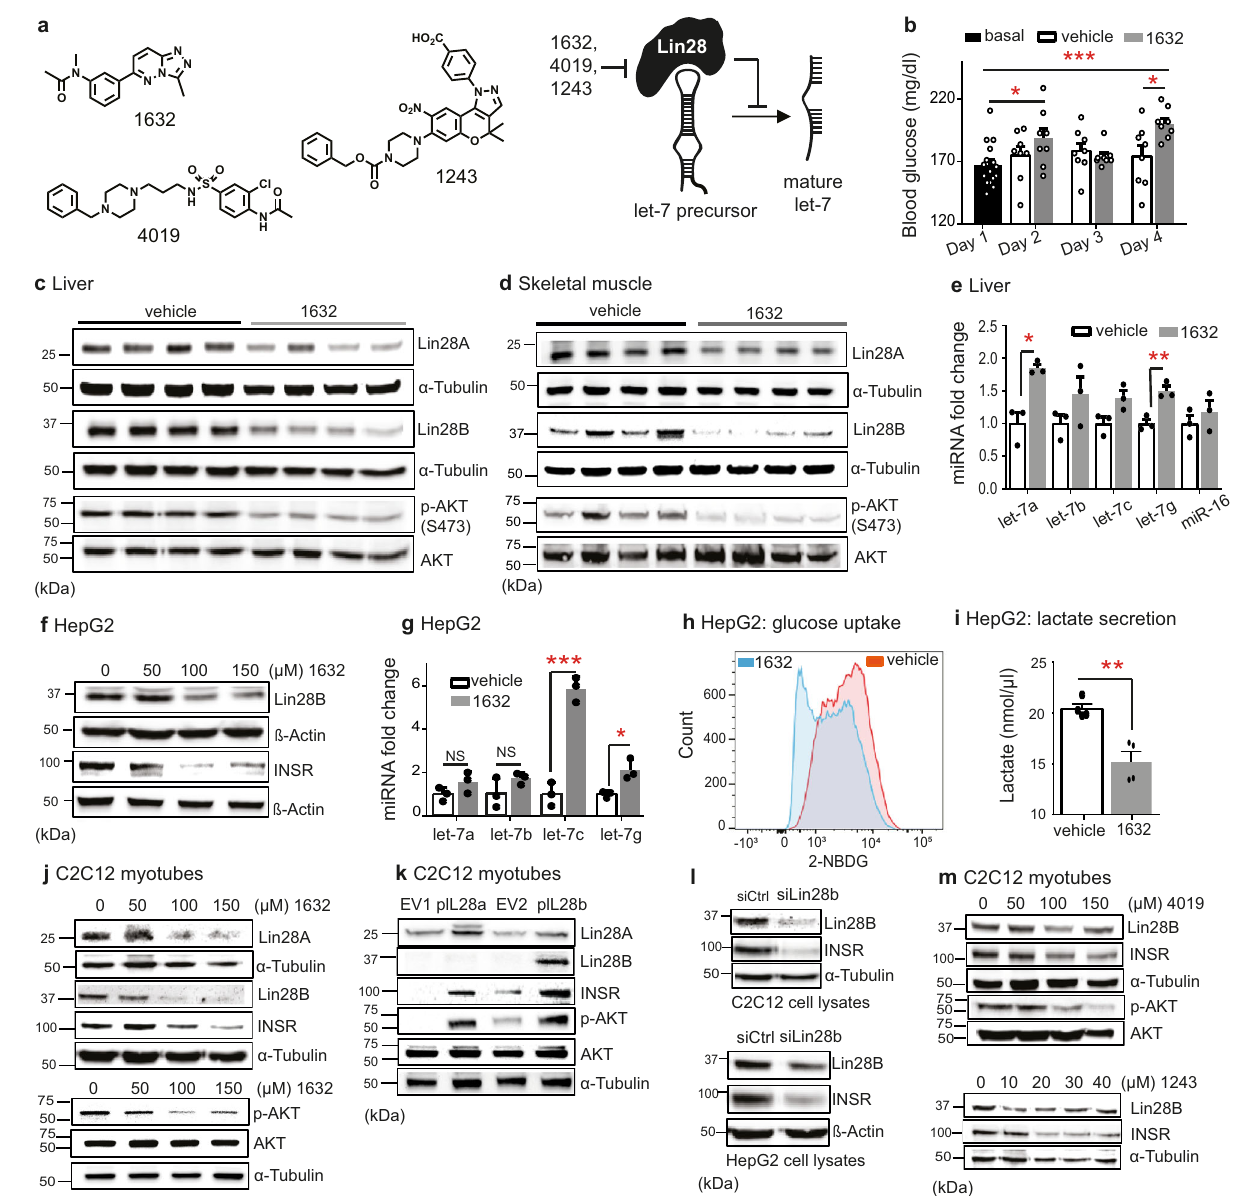
Fig. 1 | Lin28A/B inhibition suppresses insulin-PI3K-mTOR signalling in liver and skeletal muscle. a C1632, C4019 and C1243 inhibit Lin28 and derepress let-7 biogenesis. b 7-week-old male C57BL/6J mice received intraperitoneal injections of C1632 (50mg/kg) or vehicle for 5 consecutive days. Blood glucose was monitored daily ( n =8 mice/group; basal vs 1632 Day 2: *P =0.0457 and Day 4: **** P <0.0001; vehicle vs 1632-Day 4: * P =0.0224). c Immunoblot analysis for Lin28A, Lin28B, p-AKT(S473), AKT in liver lysates in treated mice from ( b ) (Loading control: α -